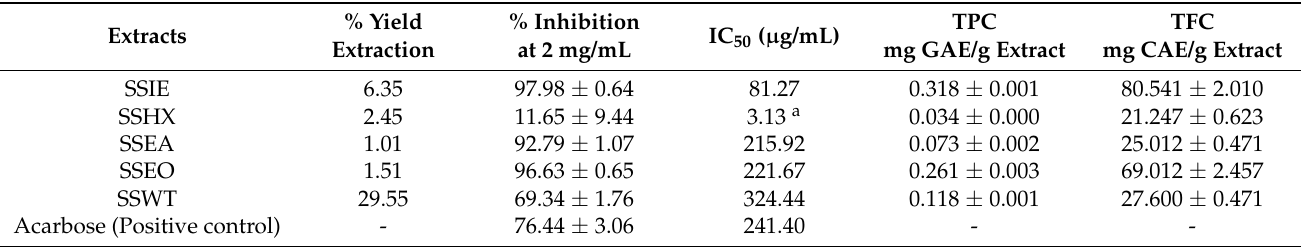
Table 1. Extraction yield, alpha-glucosidase inhibition, TPC, and TFC of S. stramonifolium crude